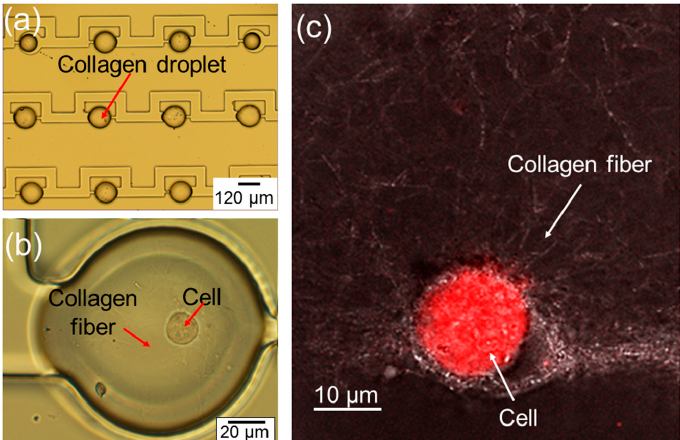
Figure 2. ( a ) Photo of arrayed microtissues stored in storage chambers; ( b ) close-up of one microtissue containing one cell; ( c ) confocal image of one cell inside polymerized collagen fiber, forming a microtissue.